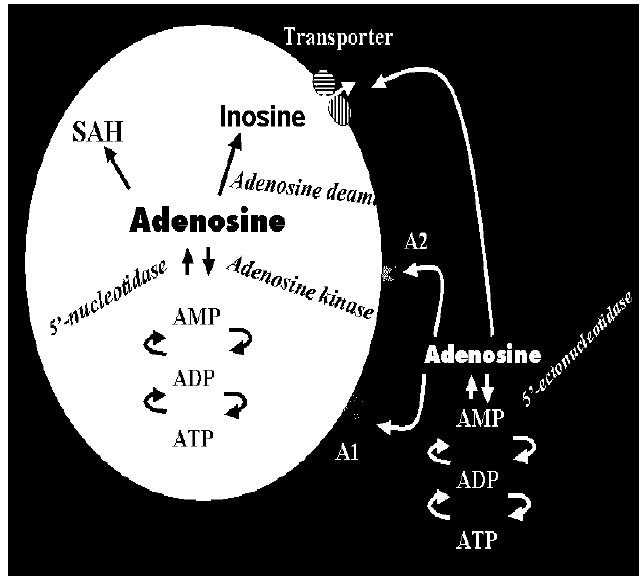
FIGURE 2 . Schematic of main intra- and extracellular metabolic pathways of adenosine . Adenosine is formed from AMP intracellularly by the enzymes ATP-ase, ADP-ase, and 5'-nucleotidase, and extracellularly by the respective ectoenzymes. Adenosine kinase converts adenosine to AMP, while adenosine deaminase converts it to inosine. The third enzyme to metabolize adenosine is S- adenosylhomocysteine hydrolase, which converts adenosine to S-adenosylhomocysteine (SAH). Adenosine concentration between the intra- and extracellular spaces is equilibrated by nucleoside transporters. Adenosine's effects on cells are mediated through specific receptors. Abbreviations: A1, A1 adenosine receptor subtype; A2, A2 adenosine receptor subtype; ADP, adenosine diphosphate; AMP, adenosine 5'-monophosphate: ATP, adenosine triphosphate (modified from